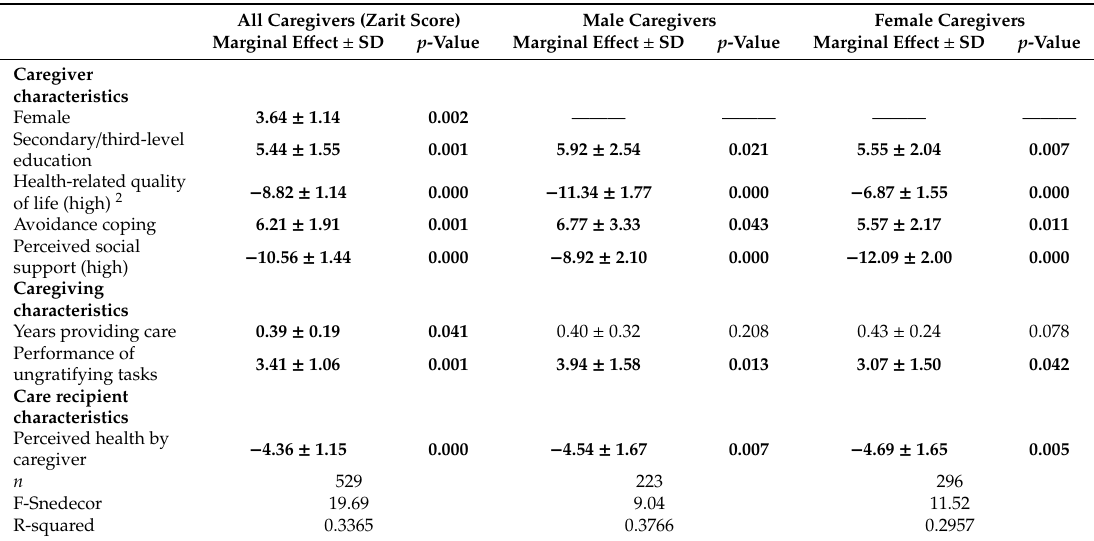
Table 2. Variables associated with informal caregiver burden (Zarit score): multivariate analysis di ff erentiated by gender 1